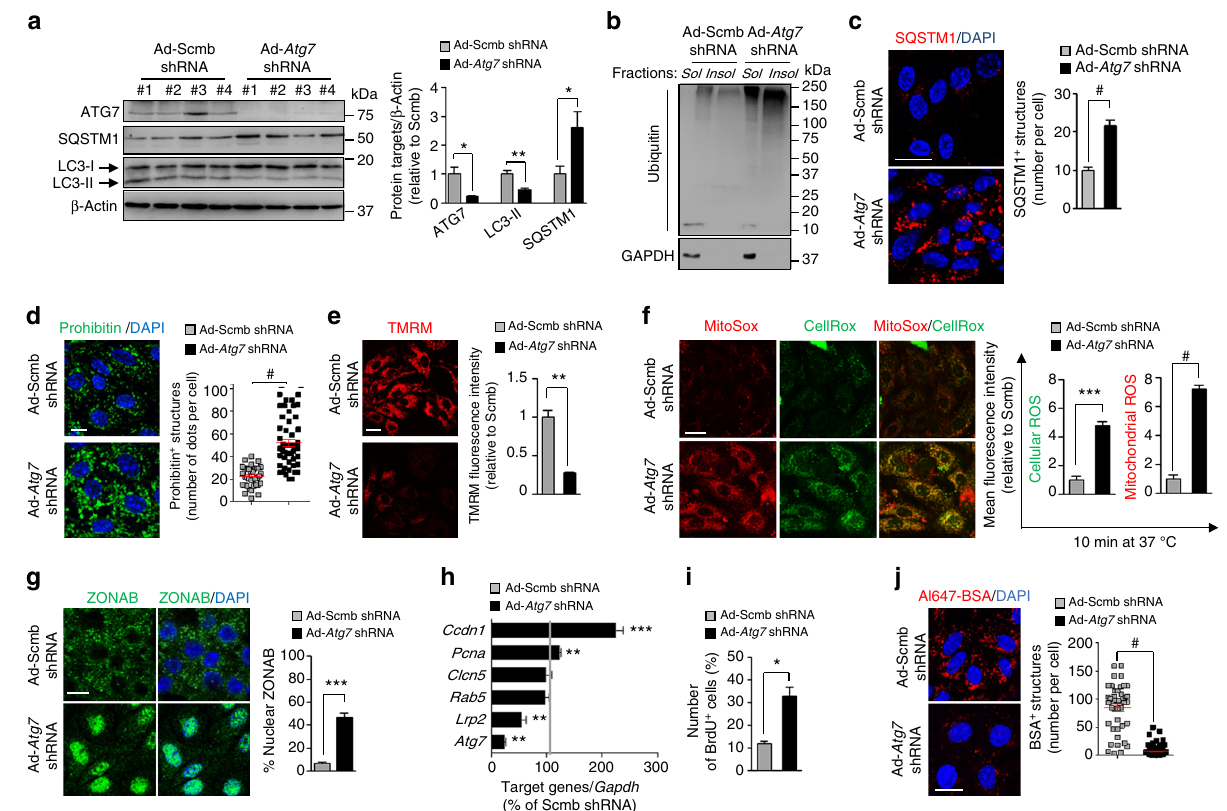
Fig. 5 Failure of autophagy causes proliferation and dedifferentiation of PT cells. a – j mPTCs were transduced with either scrambled (Scmb) or Atg7 adenoviral shRNAs for 5 days. a Western blotting and densitometric analyses of ATG7, SQSTM1, and LC3 levels. β -Actin was used as a loading control, n = 4 independent experiments. b Representative western blotting of the soluble and insoluble fractions derived from mPTCs and immunoblotted for ubiquitin and GAPDH; n = 3 independent experiments. c Confocal analysis of SQSTM1 + structures (red) in mPTCs ( n = 143 cells pooled from four Ctns kidneys per condition) and d of prohibitin + structures (green) in mPTCs ( n = 40 – 50 cells pooled from three mouse kidneys per condition). e The cells were loaded with tetramethylrhodamine methyl ester (TMRM; mitochondrial membrane potential fl uorescent probe, 50 nM for 30 min at 37 °C) and analysed by confocal microscopy. Quanti fi cation of TMRM fl uorescence intensity obtained from fi ve randomly selected fi elds per condition, with each containing ~ 20 – 25 cells. f mPTCs were loaded with CellROX (green, cellular ROS probe; 5 µ M for 10 min at 37 °C) and Mito SOX (red, mitochondrial ROS probe; 2.5 µ M for 10 min at 37 °C) analysed by confocal microscopy. Quanti fi cation of CellROX or MitoSOX fl uorescence intensity obtained from three randomly selected fi elds per condition, with each containing ~ 20 – 25 cells. g mPTCs were immunostained with anti-ZONAB (green) antibody and analysed by confocal microscopy. Quanti fi cation of ZONAB + nuclei (in percentage of the total nuclei) obtained from fi ve randomly selected fi elds per condition, with each containing ~ 20 – 25 cells. h The mRNA levels of Atg7 , Clcn5 , Rab5 , Lrp2 , Ccdn1 , and Pcna were analysed by real-time PCR ( n = 4 independent experiments). i mPTCs were loaded with bromodeoxyuridine (BrdU, 1.5 μ g ml − 1 for 16 h at 37 °C), immunostained with anti-BrdU antibody and analysed by confocal microscopy. Quanti fi cation of numbers of BrdU + cells (in percentage of total nuclei) obtained from fi ve randomly selected fi elds per condition, with each containing ~ 20 – 25 cells. j The cells were loaded with Al647-BSA (50 μ g ml − 1 for 15 min at 37 °C) and imaged by confocal microscopy. Quanti fi cation of numbers of Al647-BSA + structures ( n = 49 – 85 cells pooled from three mouse kidneys per condition; each point representing the number of BSA + structures in a cell). Plotted data represent mean ± SEM. Two-tailed paired Student ’ s t -test, * P < 0.05, ** P < 0.01, *** P < 0.001, and # P < 0.0001 relative to mPTCs transduced with Scmb shRNAs; NS, not signi fi cant. Nuclei are counterstained with DAPI (blue). Scale bars are 10 μ